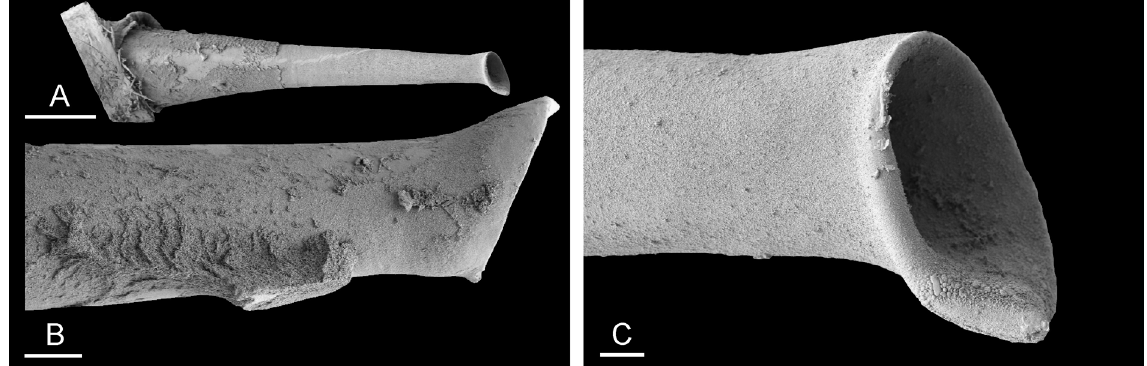
Fig. 20. Paromoionchis tumidus (Semper, 1880) comb. nov. unit #3, spine of accessory penial gland, Papua New Guinea, Madang. A . [5432] (MNHN IM-2013-10478). B . [5433] (MNHN IM-2013-10479). C . Distal tip of spine, same as A. Scales: A = 100 μm; B = 20 μm; C = 10